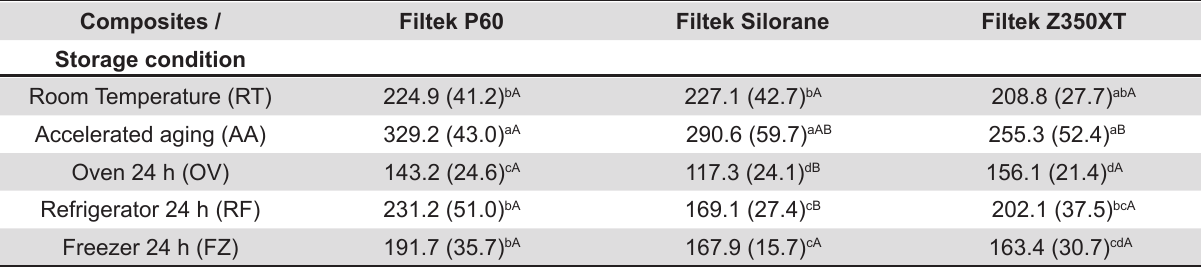
Table 1- Mean of flexural strength (S) regarding interaction Composite x Syringe storage condition